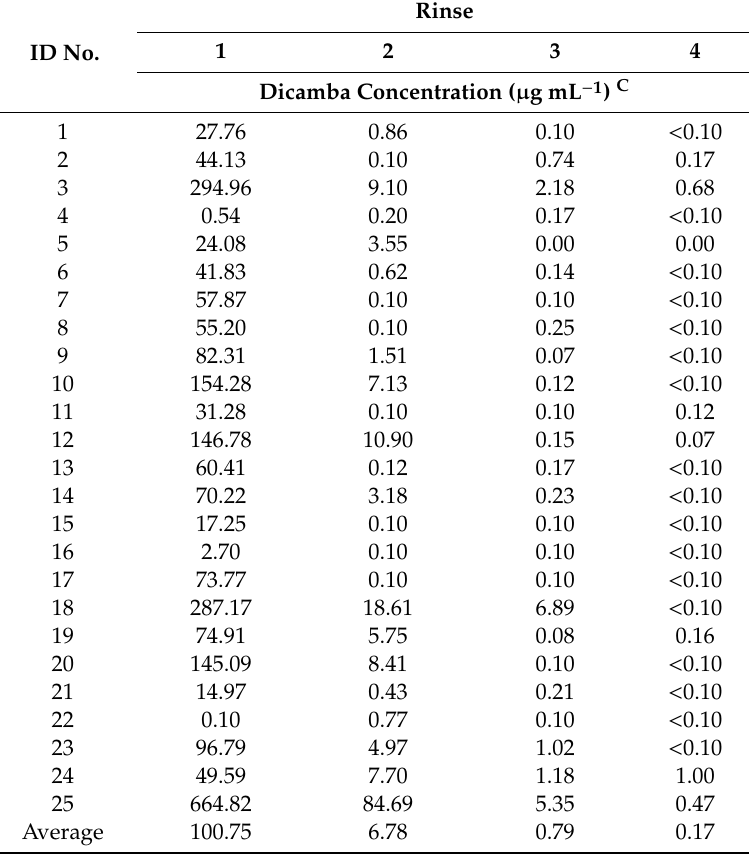
Table 5. Dicamba concentration in surveyed sprayers rinsates from each rinse A,B .